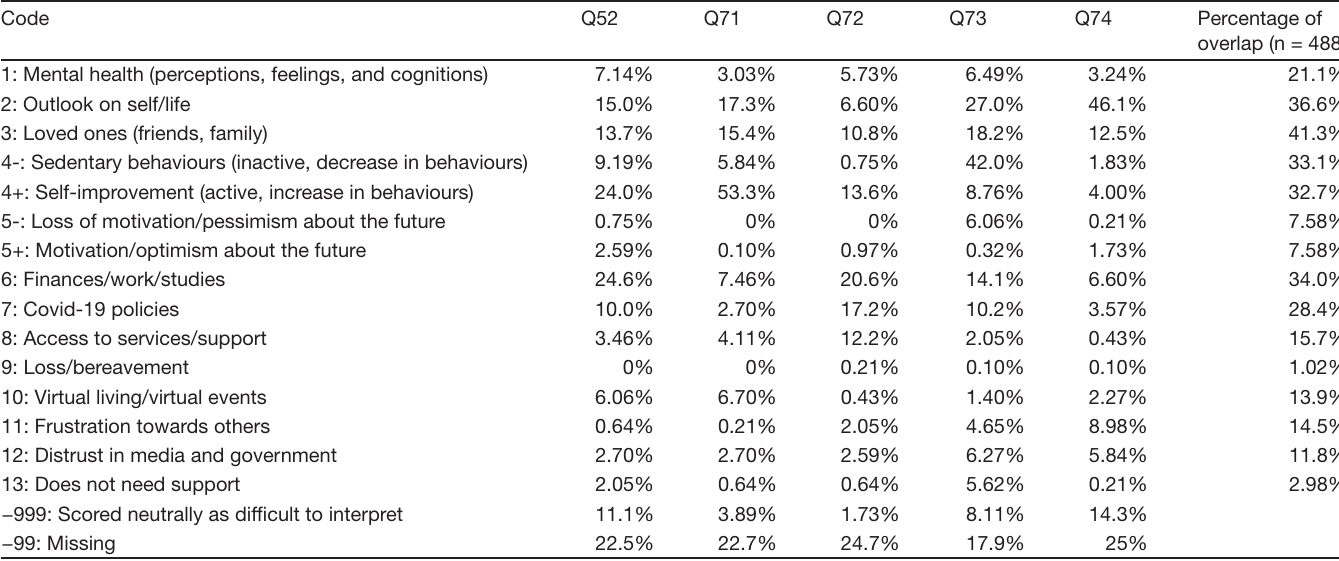
Table 4. Distribution of codes for each question (all n = 925)